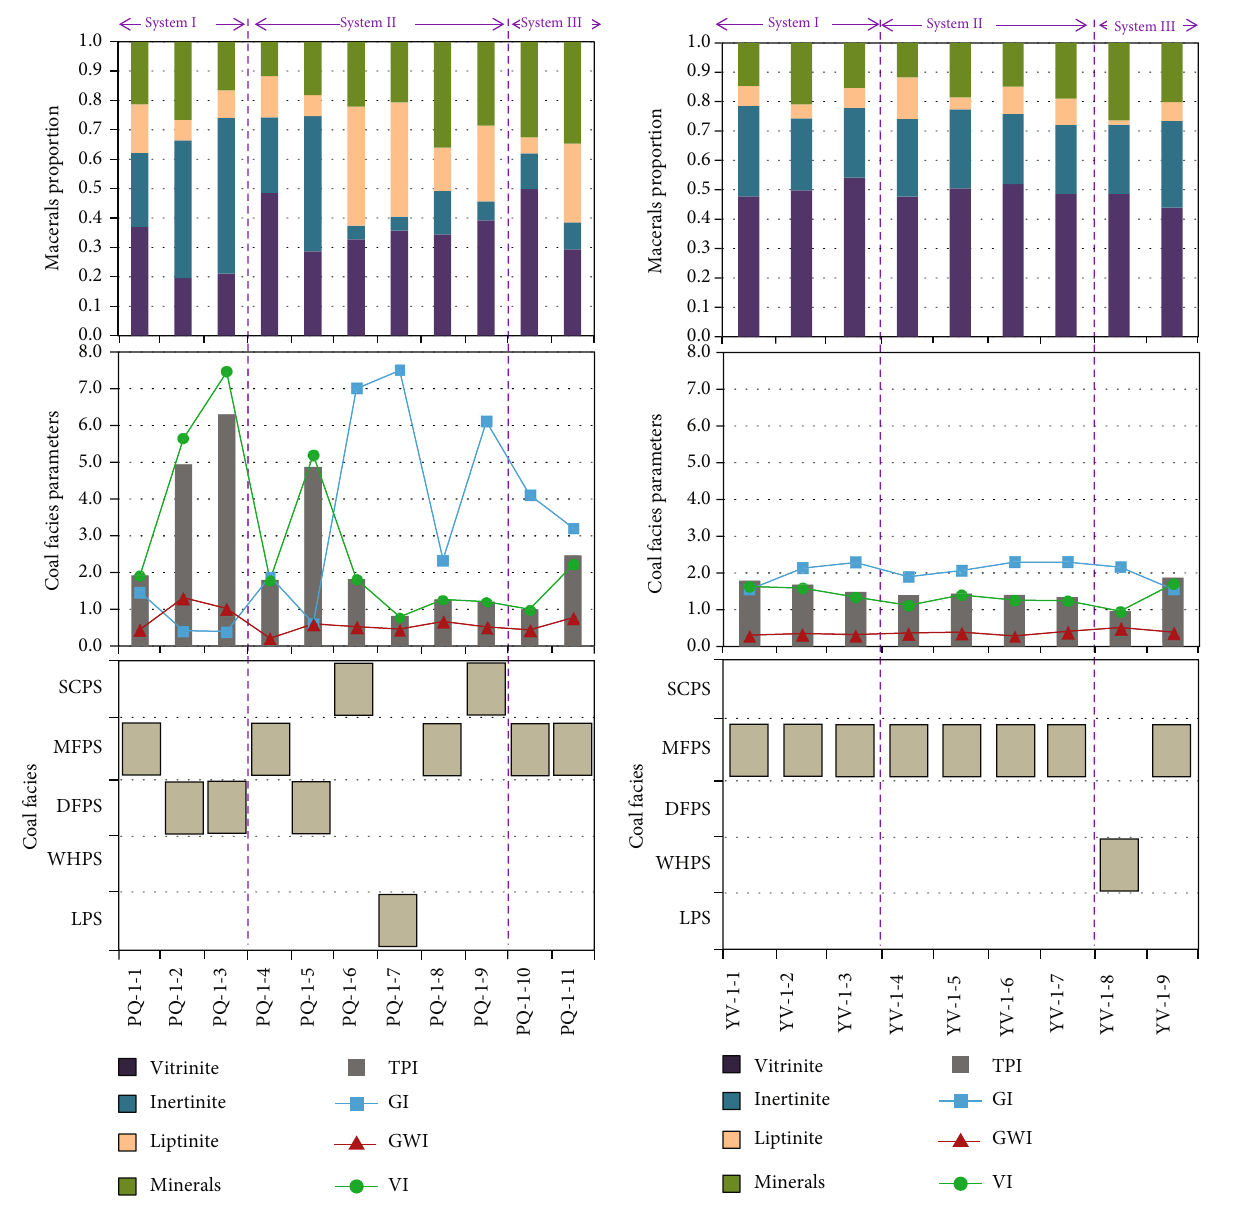
Figure 5: Columnar sequences of coal facies and its corresponding parameters of studied coal samples. (a) PQ-1 well; (b) YV-1